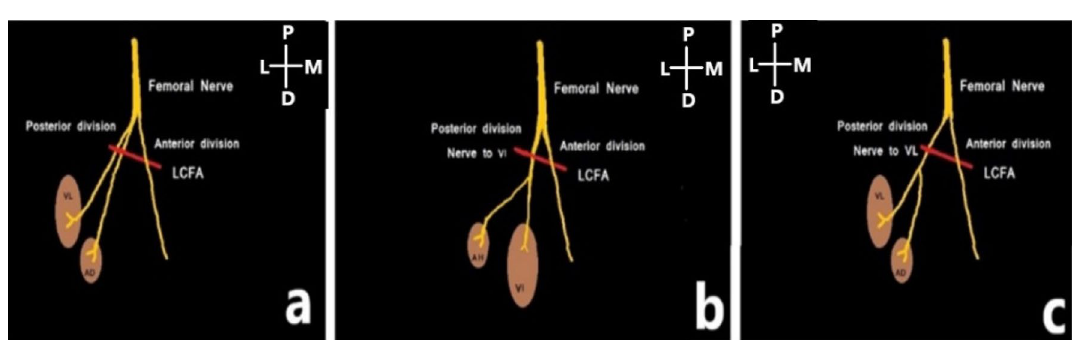
Figure 8. Schematic diagram showing the nerve supply to the additional muscle head; LCFA- lateral circumflex femoral